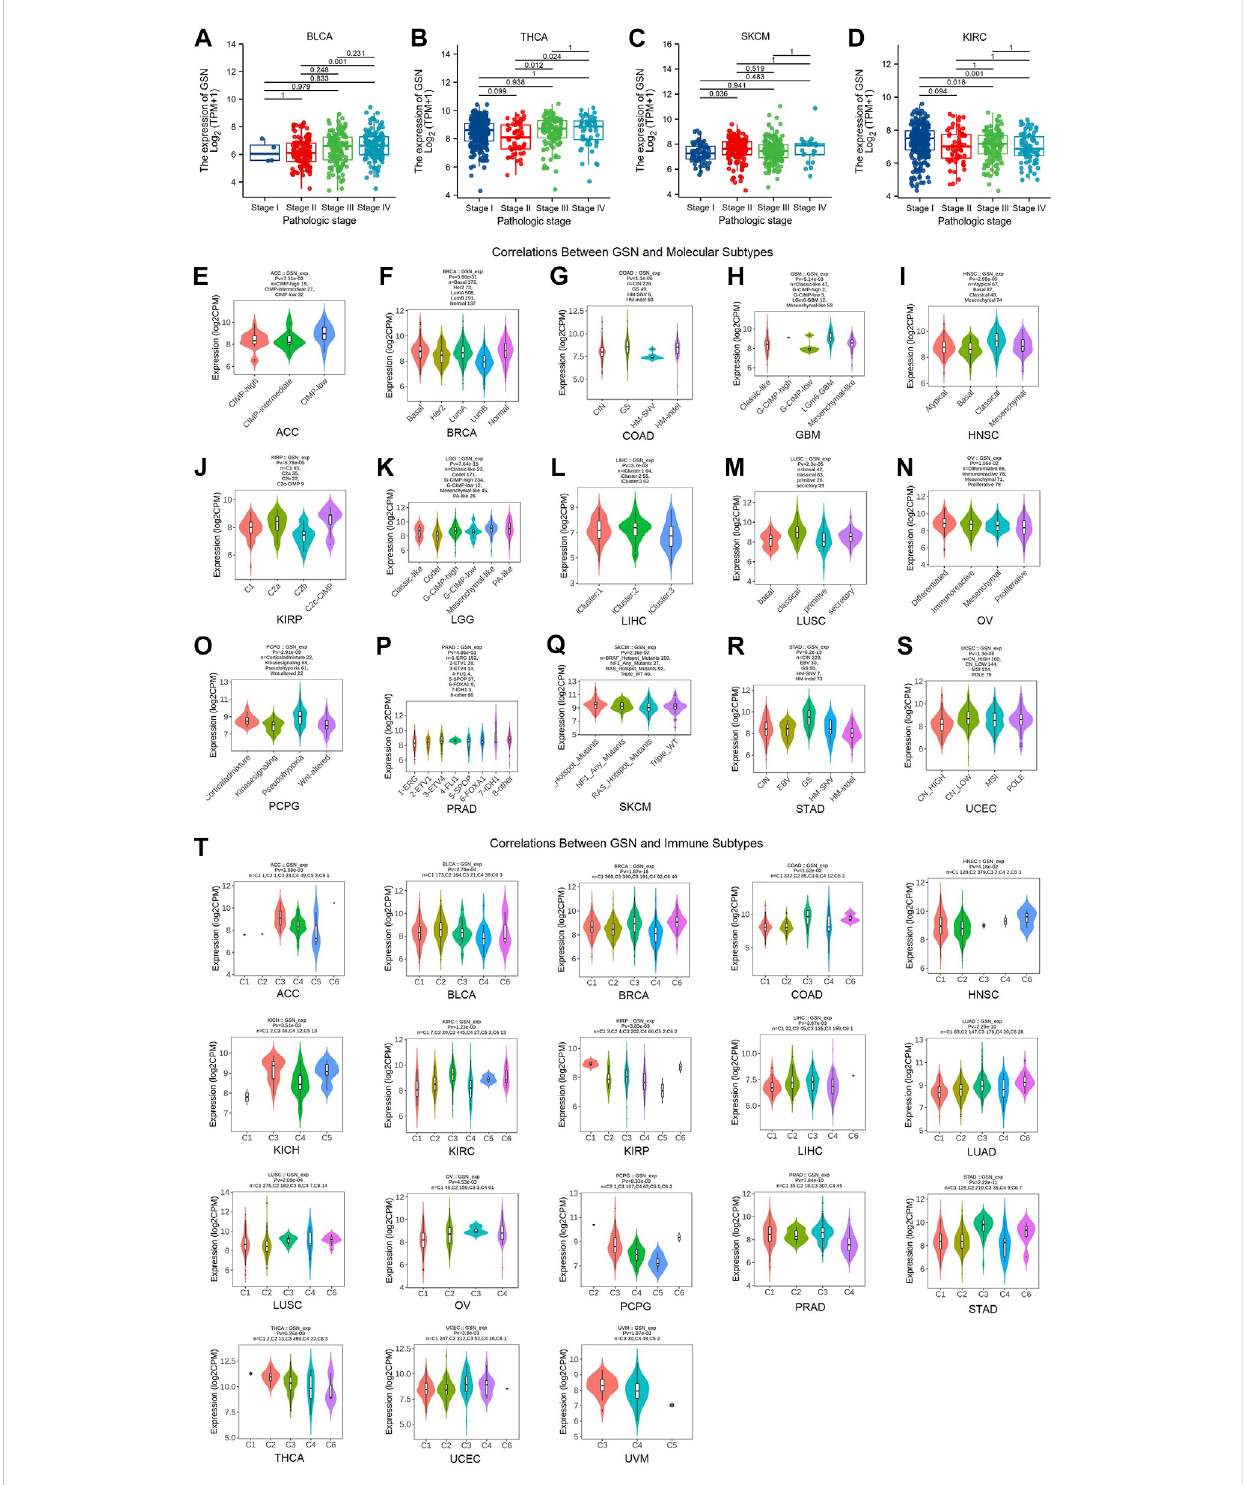
FIGURE 2 Correlation of GSN expression with different tumor stages, molecular subtypes, and immune subtypes. Correlation between GSN expression and different tumor stages, including BLCA (A) , THCA (B) , SKCM (C) , KIRC (D) . Correlations between molecular subtypes and GSN expression across TCGA tumors, including (E) ACC; (F) BRCA; (G) COAD; (H) GBM; (I) HNSC; (J) KIRP; (K) LGG; (L) LIHC; (M) LUSC; (N) OV; (O) PCPG; (P) PRAD; (Q) SKCM; (R) STAD; (S) UCEC. (T) Correlations between immune subtypes and GSN expression across TCGA tumors, including ACC, BLCA, BRCA, COAD, HNSC, KICH, KIRC, KIRP, LIHC, LUAD, LUSC, OV, PCPG, PRAD, STAD, THCA, UCEC and UVM. C1 (wound healing), C2 (IFN-g dominant), C3 (in fl ammatory), C4 (lymphocyte deplete), C5 (immunologically quiet), and C6 (TGF-b